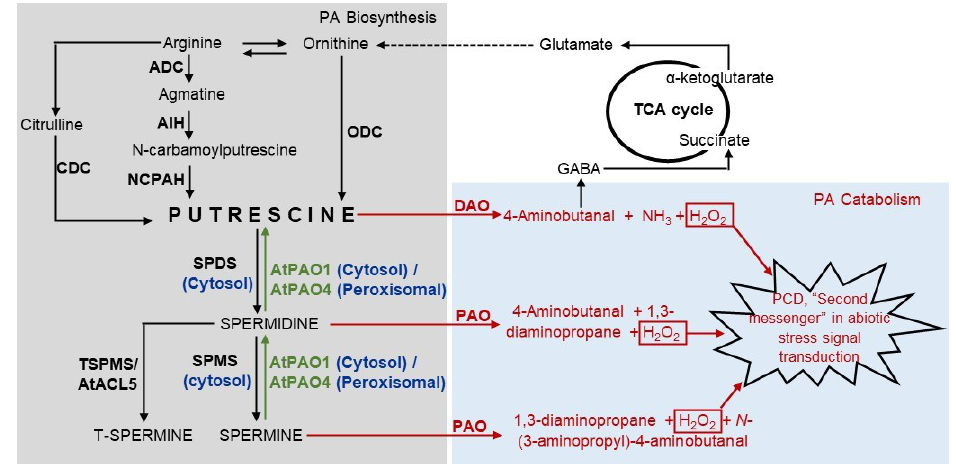
Figure 1. Diagrammatic representation of PA catabolism, anabolism, and their links with the TCA cycle. Grey and blue highlighted boxes represent biosynthesis and catabolism, respectively. En- zymes are represented by bold text. Green texts and arrows represent back conversions. Red texts and arrows represent catabolism. Dotted arrow represents the multi-step conversion. ACL —